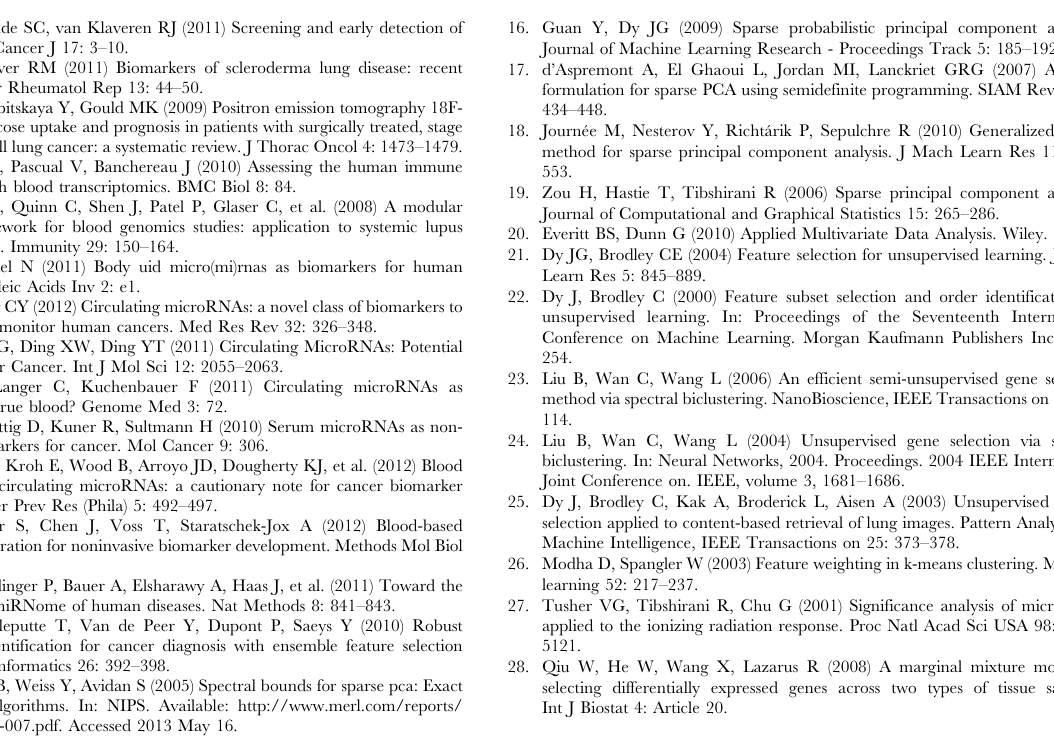
Table S11, Validation analysis for carcinoma in situ / squamous cell carcinoma. Validation of our method